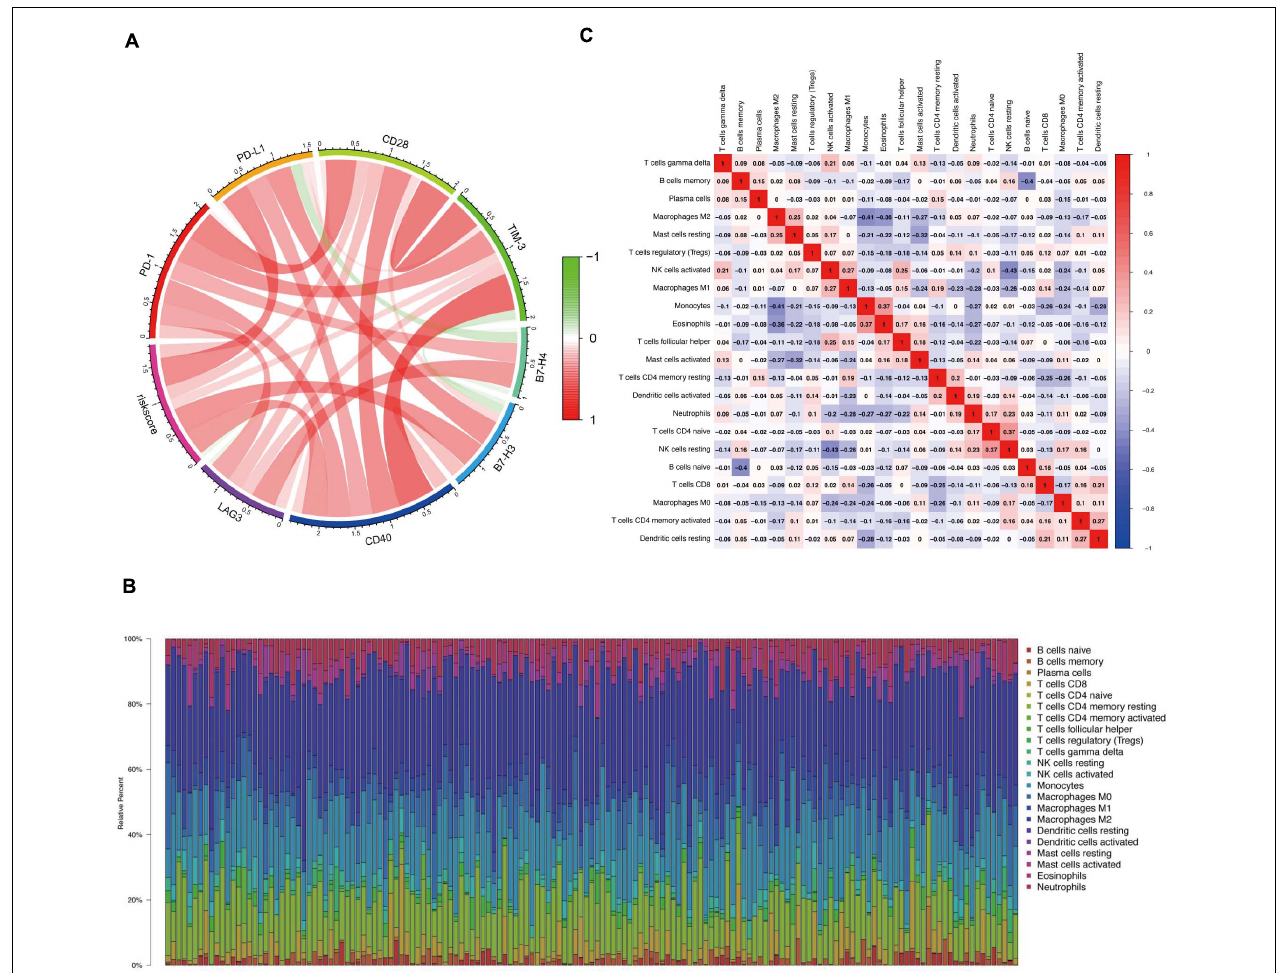
FIGURE 6 | Correlation between the risk score and immune response and the distribution of immune infiltration in GBM. (A) Circos plot shows the relationship between the risk score and the expression levels of some important immune checkpoints in GBM. (B) The proportions of immune cells in each GBM sample are indicated with different colors, and the lengths of the bars in the bar chart indicate the levels of the immune cell populations. (C) Correlation matrix for all 22 immune cell proportions. Some immune cells were negatively related, represented in blue, and others were positively related, represented in red. The darker the color, the higher the